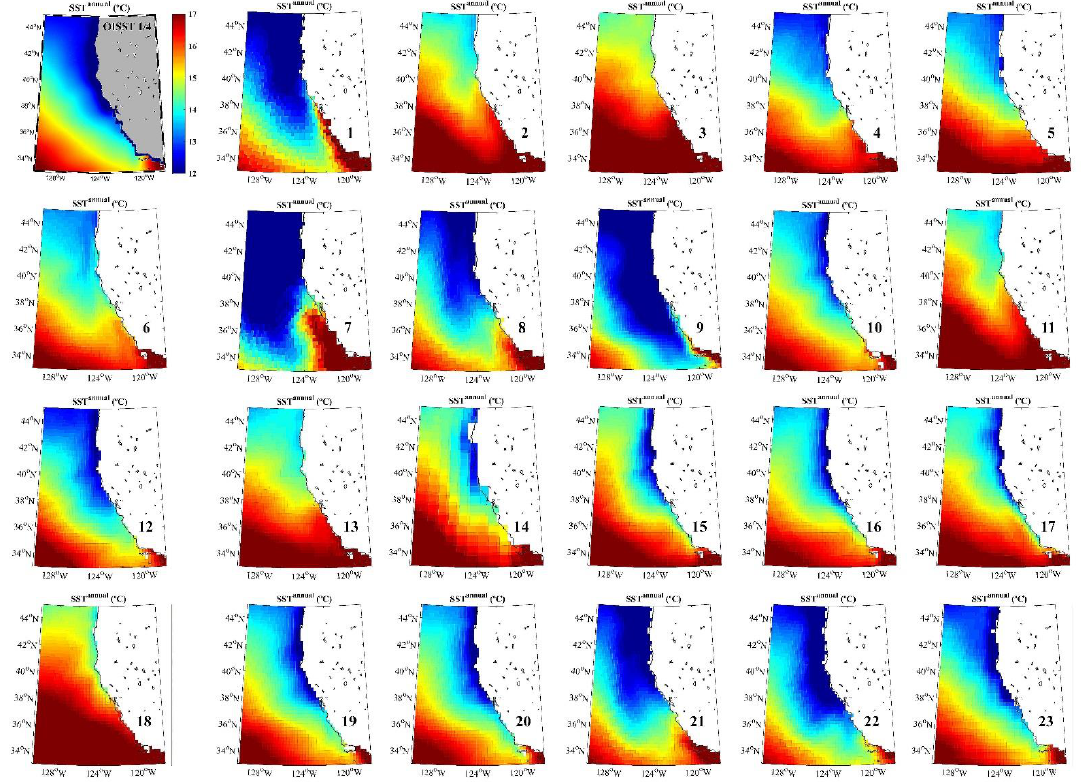
Figure 8. Mean of the annual SST ( ◦ C) for the California upwelling system from 1982 to 2014. The numbers of each map refer to Table